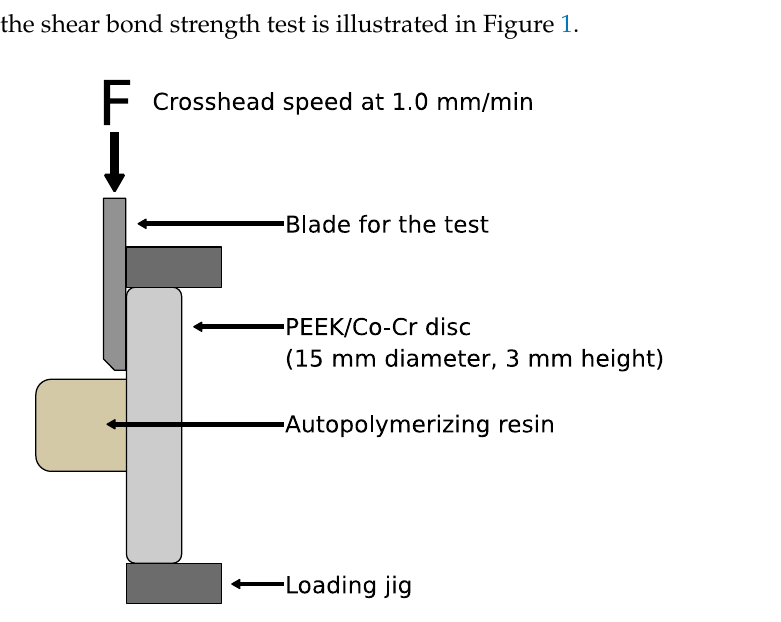
Figure 1. Shear bond strength measurement.